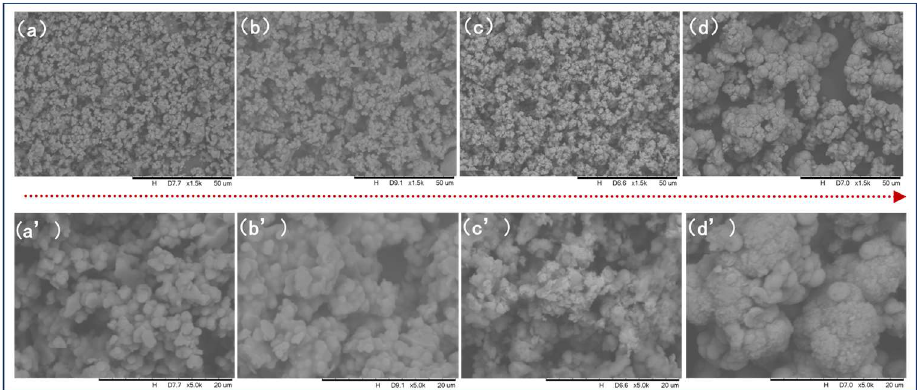
Figure 5. SEM images of morphology evolvement of FePO 4 ·2H 2 O during the experiment: ( a ) 0 min; ( b ) 30 min; ( c ) 150 min; ( d ) 450 min; ( a’ – d’ ) are images with the higher magnification at the corre- sponding times (0 min, 30 min, 150 min, 450 min).